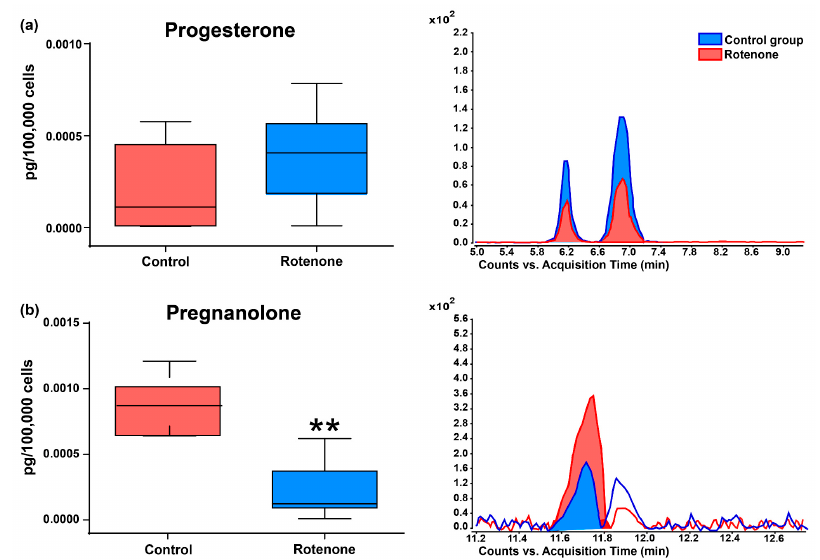
Figure 3. Progesterone ( a ) and pregnanolone ( b ) concentrations in HMC3 cells’ medium determined by LC-MS/MS in microglia in resting condition (Control) or after activation by exposure to rotenone for 24 h. In ( a ), progesterone levels, illustrated in the box plot, after stimulation with rotenone increased but not significantly when compared to the control group. Peak areas corresponding to the respective median values are illustrated on the right. In ( b ), pregnanolone levels, illustrated in the box plot, were significantly lower (** p < 0.01, Mann–Whitney rank sum test) after stimulation with rotenone. Peak areas corresponding to the respective median values are illustrated on the right. The neurosteroid concentrations are expressed in pg/100,000 cells.